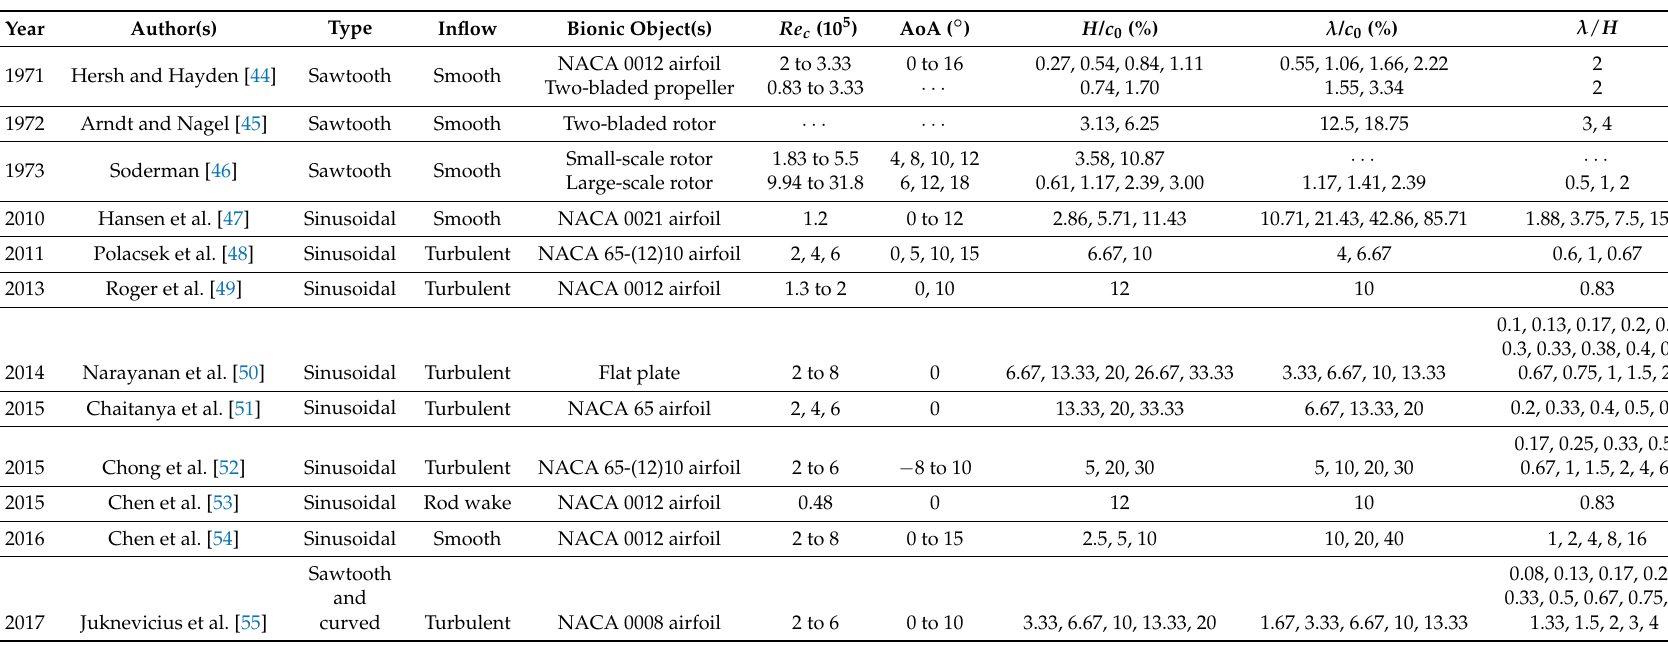
Table 3. Selected investigations of acoustic effect of leading edge serrations (“ · · · ” denotes “not clear”, H = 2 h is the distance between the root and peak, and c 0 is the chord